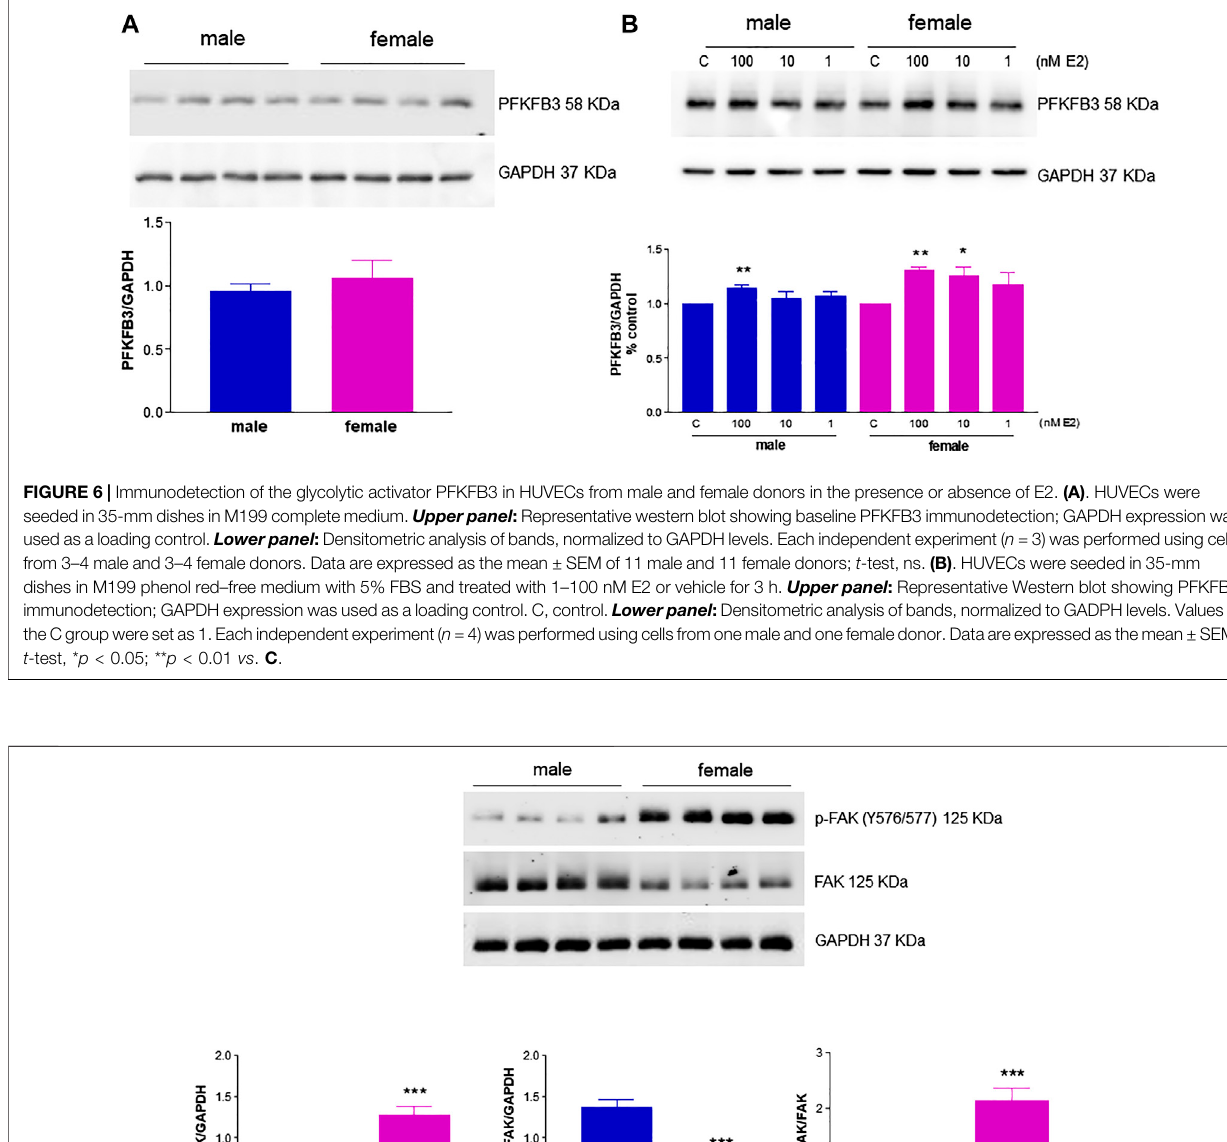
Frontiers in Pharmacology |